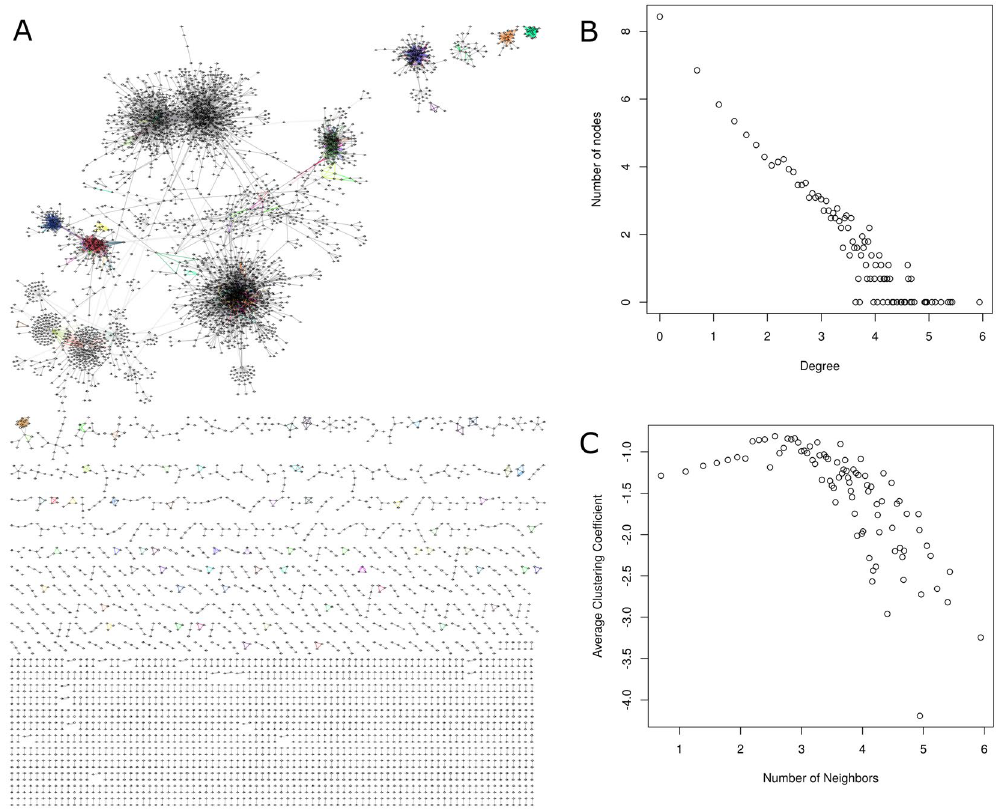
Figure 2. The Tumor GMM Gene Co-expression Network. ( A ) The graph representation of the network. Points represent nodes (i.e. transcripts) and edges represent co-expression of transcripts. Modules are identified using the link communities method and uniquely colored. Not all nodes were circumscribed into a module. ( B ) The node degree distribution plot demonstrating scale-free behavior of the network. ( C ) The average clustering coefficient plot demonstrating a hierarchical